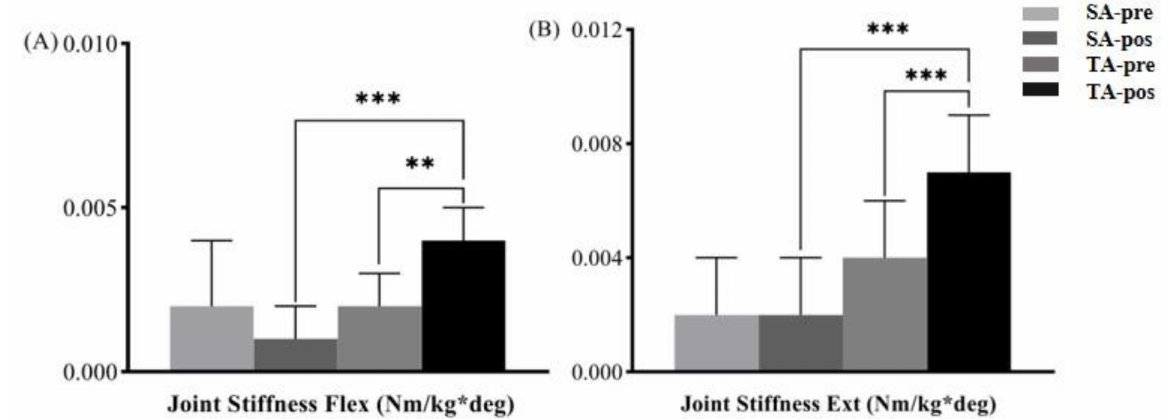
Figure 5. The simple main effects of knee joint stiffness for flexion (Flex) ( A ) and extension (Ext) ( B ) before and after acupuncture in the SA and TA groups. True acupuncture group (TA), sham acupuncture group (SA). ** p < 0.01; *** p <